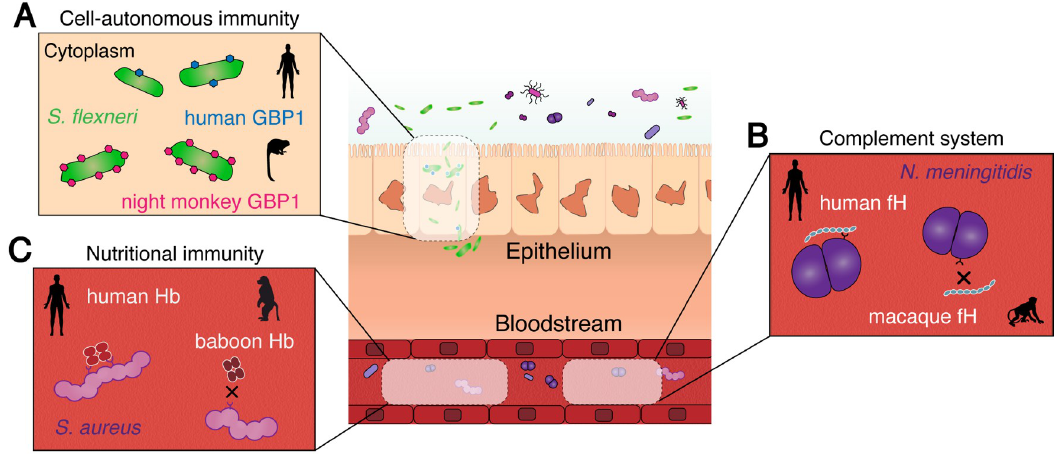
Fig 2. Interfaces of evolutionary conflict between animals and pathogenic bacteria. Three representative examples of conflicts involving human bacterial pathogens are illustrated. (A) Human GBP1 recognizes Shigella flexneri via a C-terminal PBM. Diversification within the PBM of GBP1 in night monkeys and other New World primates confers enhanced recognition to S . flexneri relative to human GBP1. (B) Pathogenic Neisseria avoid detection by the complement alternative pathway through recruitment of fH to their surface. Human fH exhibits the strongest binding to Neisseria meningitidis , whereas nonhuman primate fH is poorly recognized by these bacteria. Regions of fH corresponding to bacterial recognition sites are known to exhibit strong signatures of repeated positive selection. (C) Staphylococcus aureus scavenges host heme using the IsdB receptor. Rapidly diverging sites within alpha and beta hemoglobin in primates impair recognition by IsdB, contributing to host nutritional immunity. fH, factor H; GBP1, guanylate binding protein 1; IsdB, iron-regulated surface determinant B; PBM, polybasic